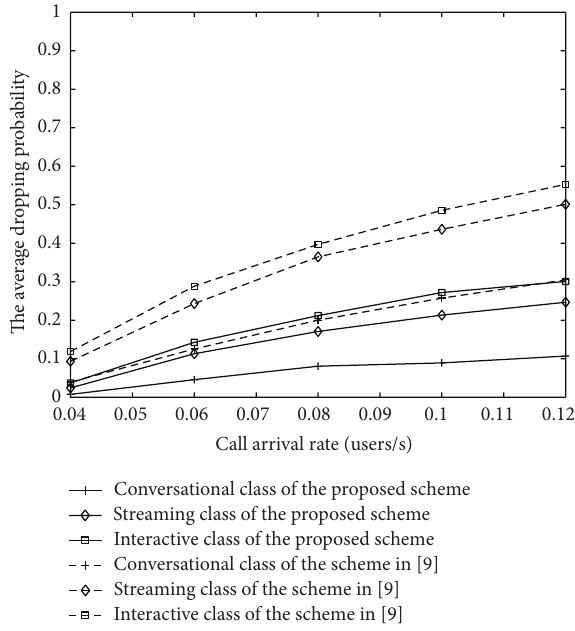
Figure 13: The dropping probability of IDMA system.